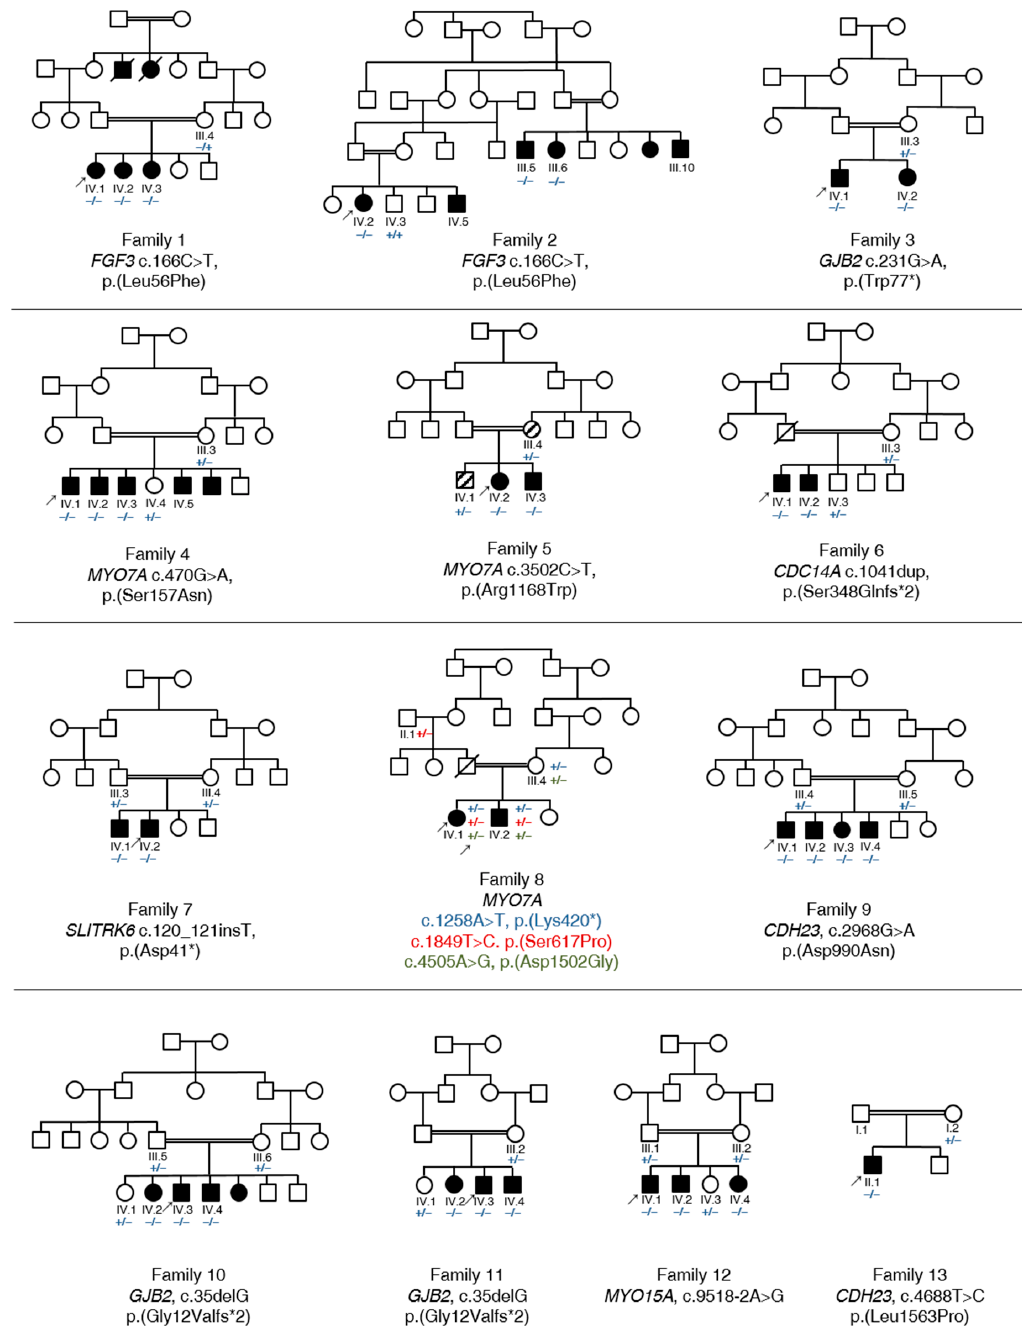
Figure 1. Pedigree and segregation analysis of known and previously undescribed variants in 13 Pakistani families with HL. All the families have a consanguineous background, marked with double lines. Affected individuals are shown in black symbols, and unaffected parents and siblings are shown in unfilled symbols. Individuals with a bone disorder, but without HL, are shown in striped symbols. Probands who were exome sequenced are marked with an arrow. Deceased individuals are marked with a diagonal line. The mutated and wild type alleles are illustrated with “ − ” (mutated) and “+” (wild type) symbols, respectively.